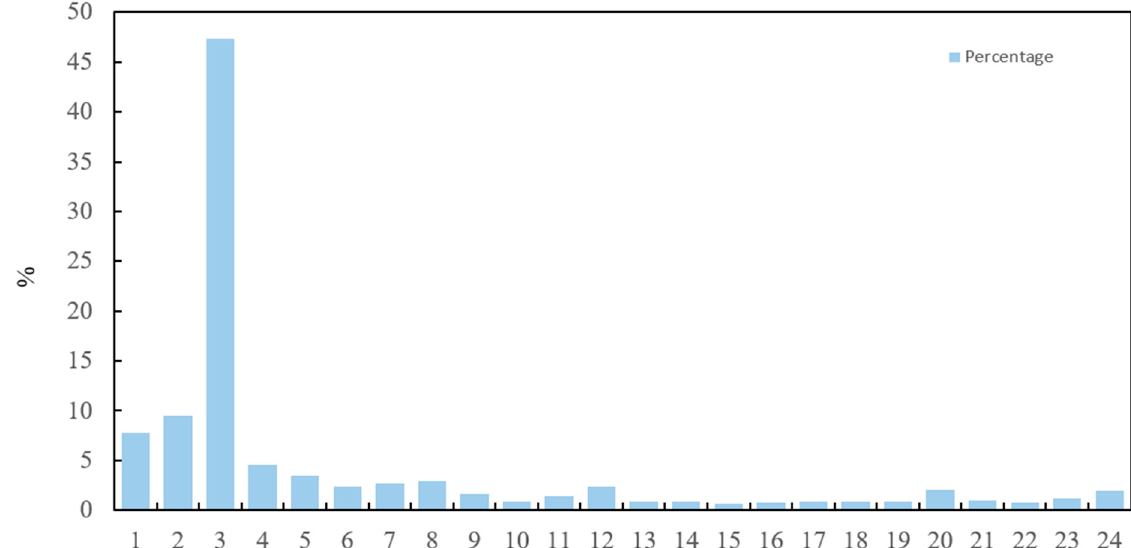
Figure 4. 24 h rainfall event pattern in Tianjin. Scope of application: 5 min ≤ t ≤ 180 min. P = 2~100 years.